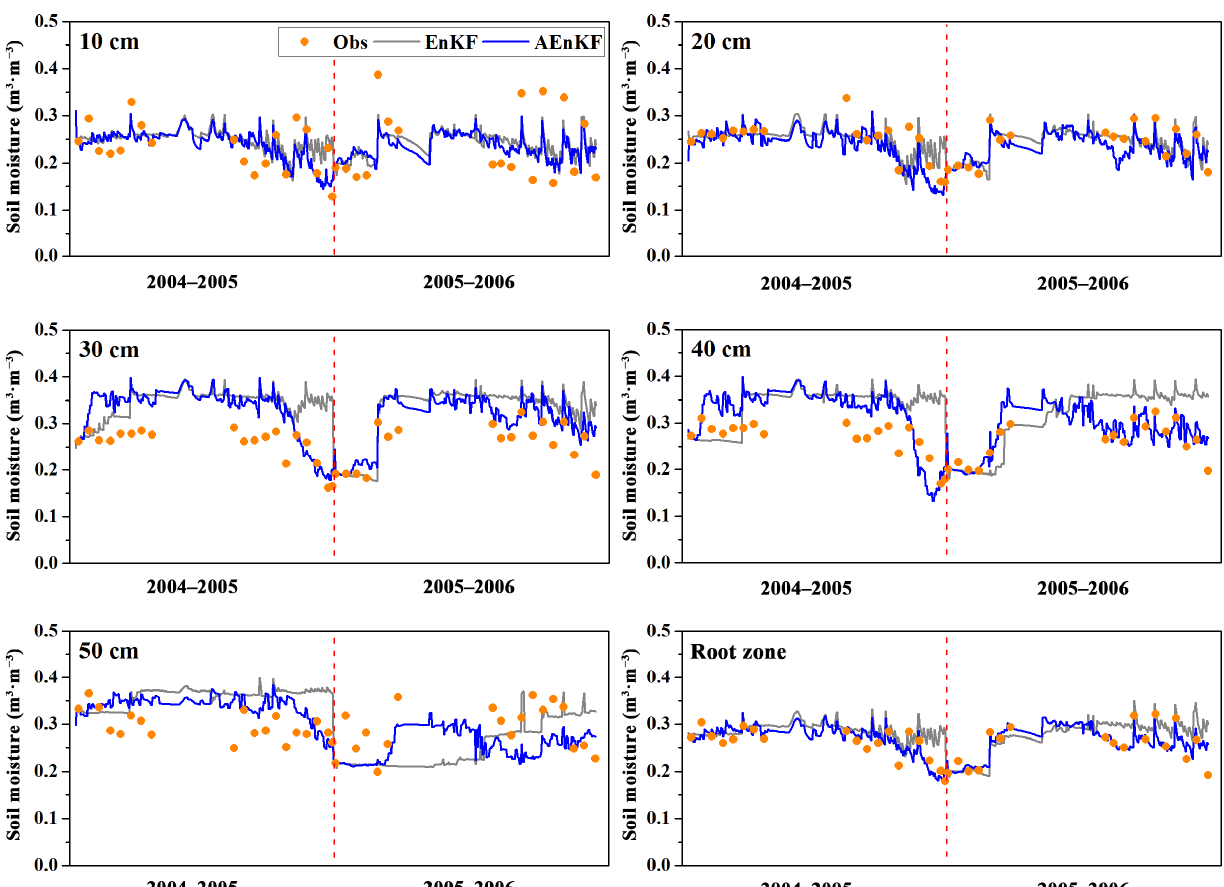
Figure 4. Soil moisture assimilation estimates using AEnKF and EnKF algorithms at different soil depths during the growing seasons of 2004–2005 and 2005–2006.